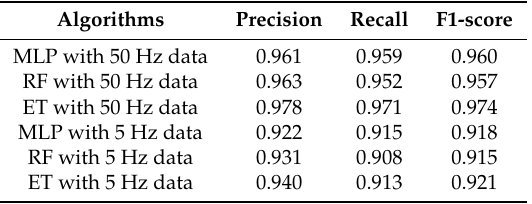
Figure 8. Confusion matrix for the three models (MLP, RF and ET) with different frequencies, after combining labels. Table 6. Precision, recall and F1-score for MLP, RF and